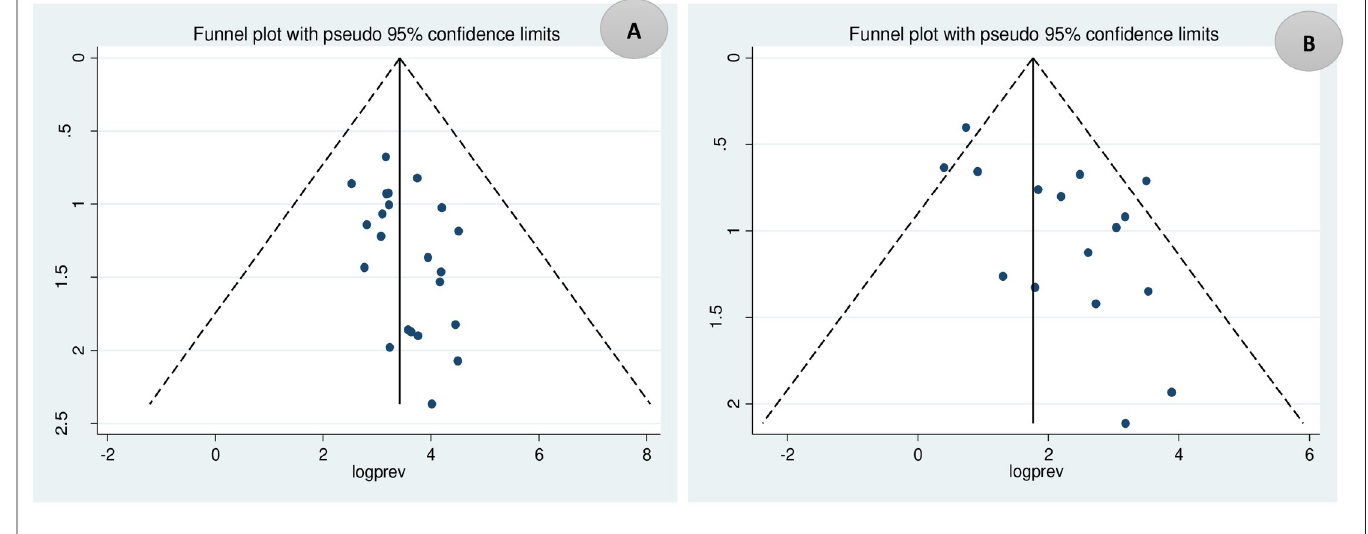
Fig 5. Funnel plot of included studies A. on the magnitude of APTT dengue fever patients B. on the magnitude of PT dengue fever patients.